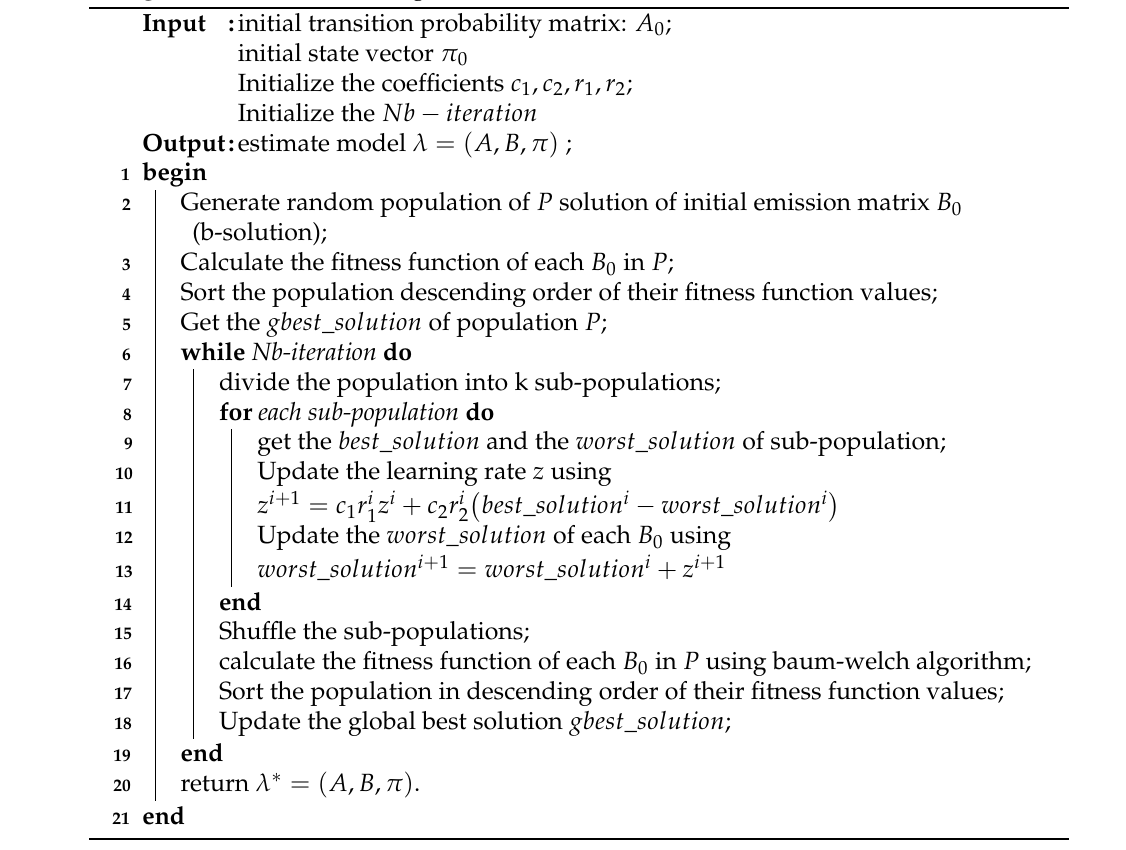
Algorithm 1: SFLA–PSO algorithm for an enhanced Baum–Welch